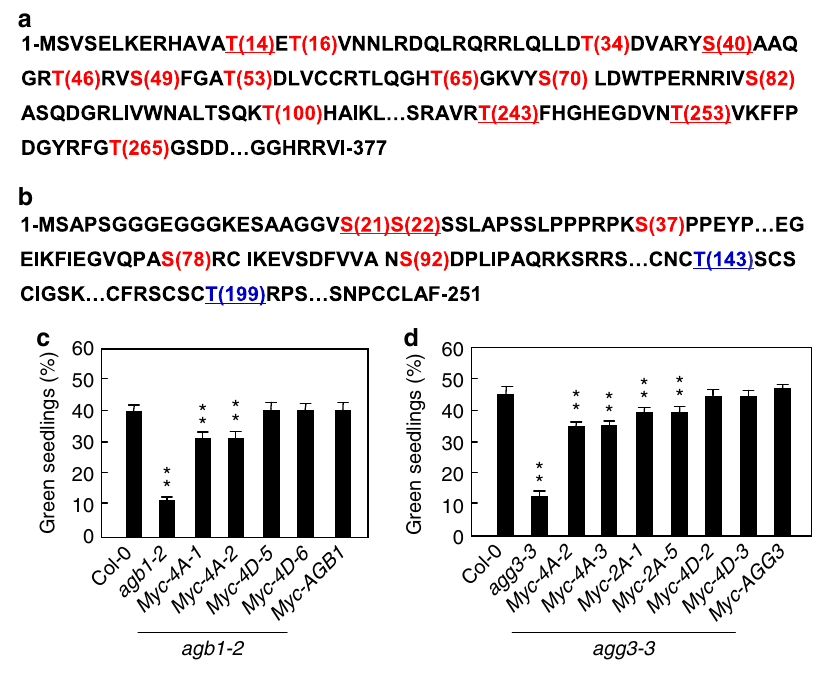
Fig. 6 Phosphorylations of AGB1 and AGG3 affect sugar responses. a , b Detection of phosphorylation sites of AGB1 ( a ) and AGG3 ( b ) by LC – MS/MS after in vitro phosphorylation reaction. AGB1 and AGG3 contain 377 and 251 residues, respectively (The omitted residues of AGB1 and AGG3 were indicated by ⋯ ). The phosphorylated residues detected by LC – MS/MS were shown in red. The possible phosphorylated residues, but not detected by LC – MS/MS, were shown in blue. Four primary phosphorylatable residues shown by underline, were substituted into phospho-dead or phospho-mimicking residues, respectively. c The percentage of the indicated seedlings with green cotyledons. agb1-2 mutants were transformed with 35S:Myc-AGB1 , 35S:Myc-AGB1 T14A, S40A,T243A,T253A ( Myc- 4A-1 and Myc- 4A-2), or 35S:Myc-AGB1 T14D,S40D,T243D,T253D ( Myc- 4D-5 and Myc- 4D-6). Independent T2 transgenic lines were selected for assay. Seedlings were grown on medium supplemented with 6% glucose medium under constant light condition for 10 days ( n ≥ 69). d The percentage of the indicated seedlings with green cotyledons. agg3-3 mutants were transformed with 35S:Myc-AGG3 , 35S:Myc-AGG3 S21A,S22A ( Myc- 2A-1, and Myc- 2A-5), 35S:Myc-AGG3 S21A,S22A,T143A,T199A ( Myc- 4A-2 and Myc- 4A-3), or 35S:Myc-AGG3 S21D,S22D,T143D,T199D ( Myc- 4D-2 and Myc- 4D-3). Independent T2 transgenic lines were selected for assay. Seedlings were grown on 6% glucose medium under constant light condition for 10 days ( n ≥ 74). Values in c , d are given as mean ± SD, ** P < 0.01 compared with Col-0 by Student ’ s t